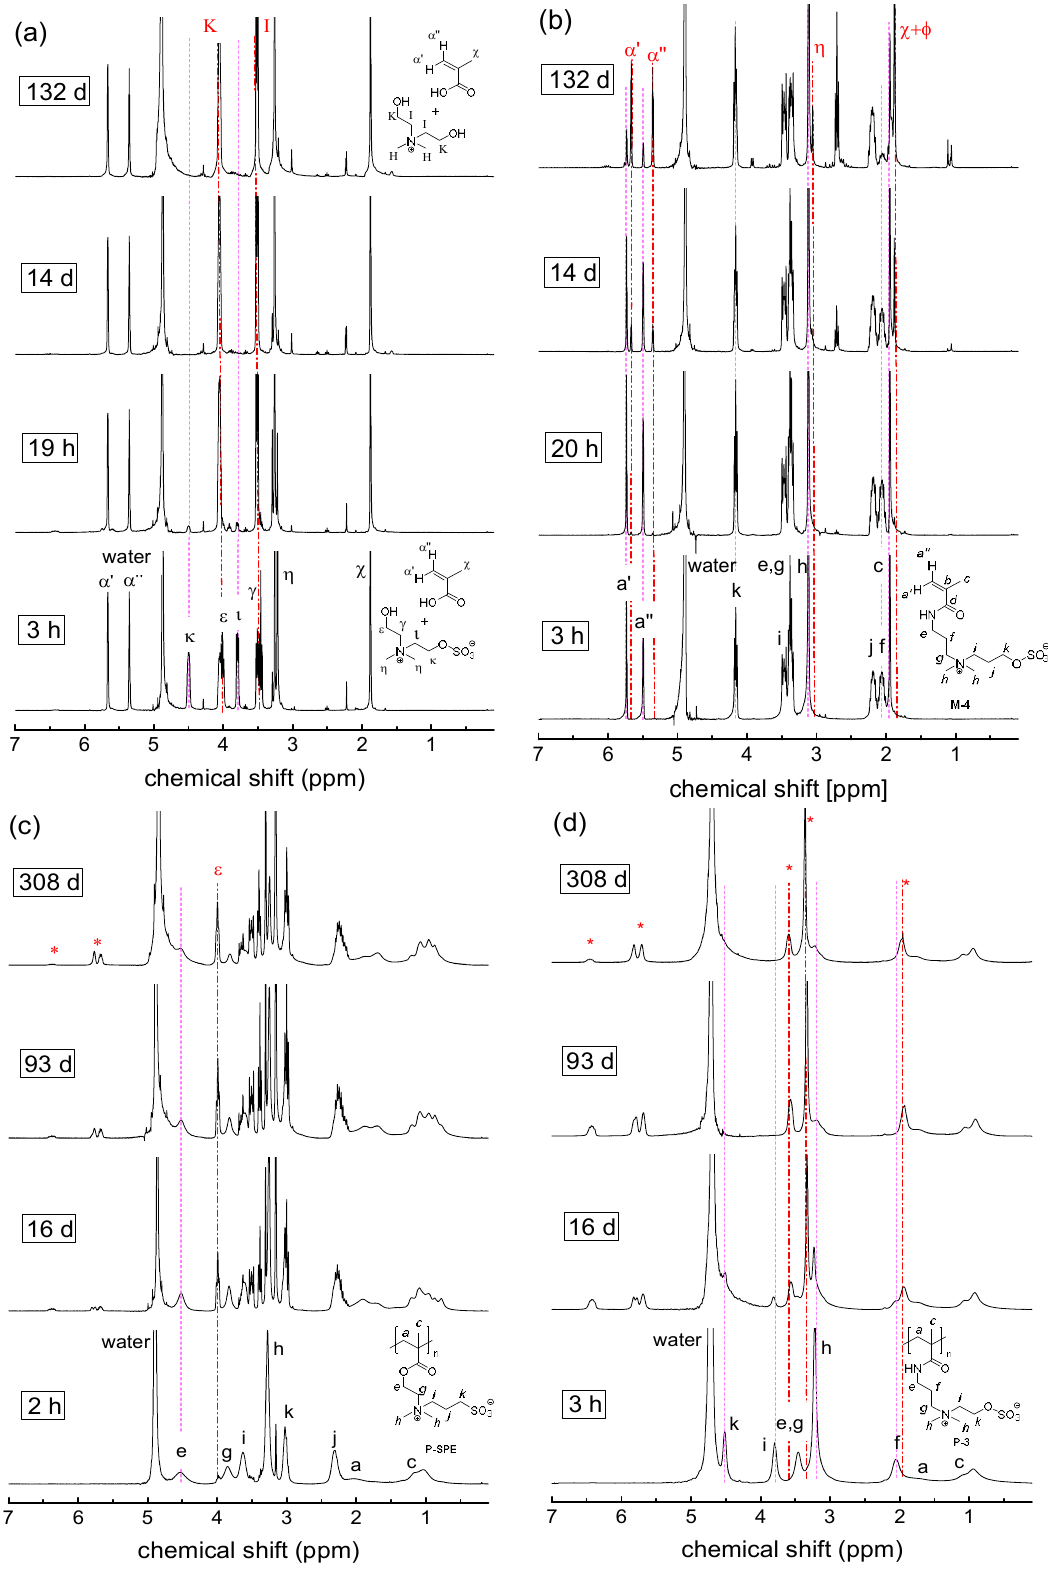
Figure 8. Evolution of the 1 H-NMR spectra over time illustrating the degradation behavior in 1 M sodium hydroxide in D 2 O (pH = 14) at room temperature for: ( a ) M-1 ; ( b ) M-4 , ( c ) P-SPE ; ( d ) P-3 . Signal attributions of the starting compounds are labeled by roman letters, signal attributions of the degradation product by corresponding Greek letters. Broken vertical lines are meant as guide to the eye.